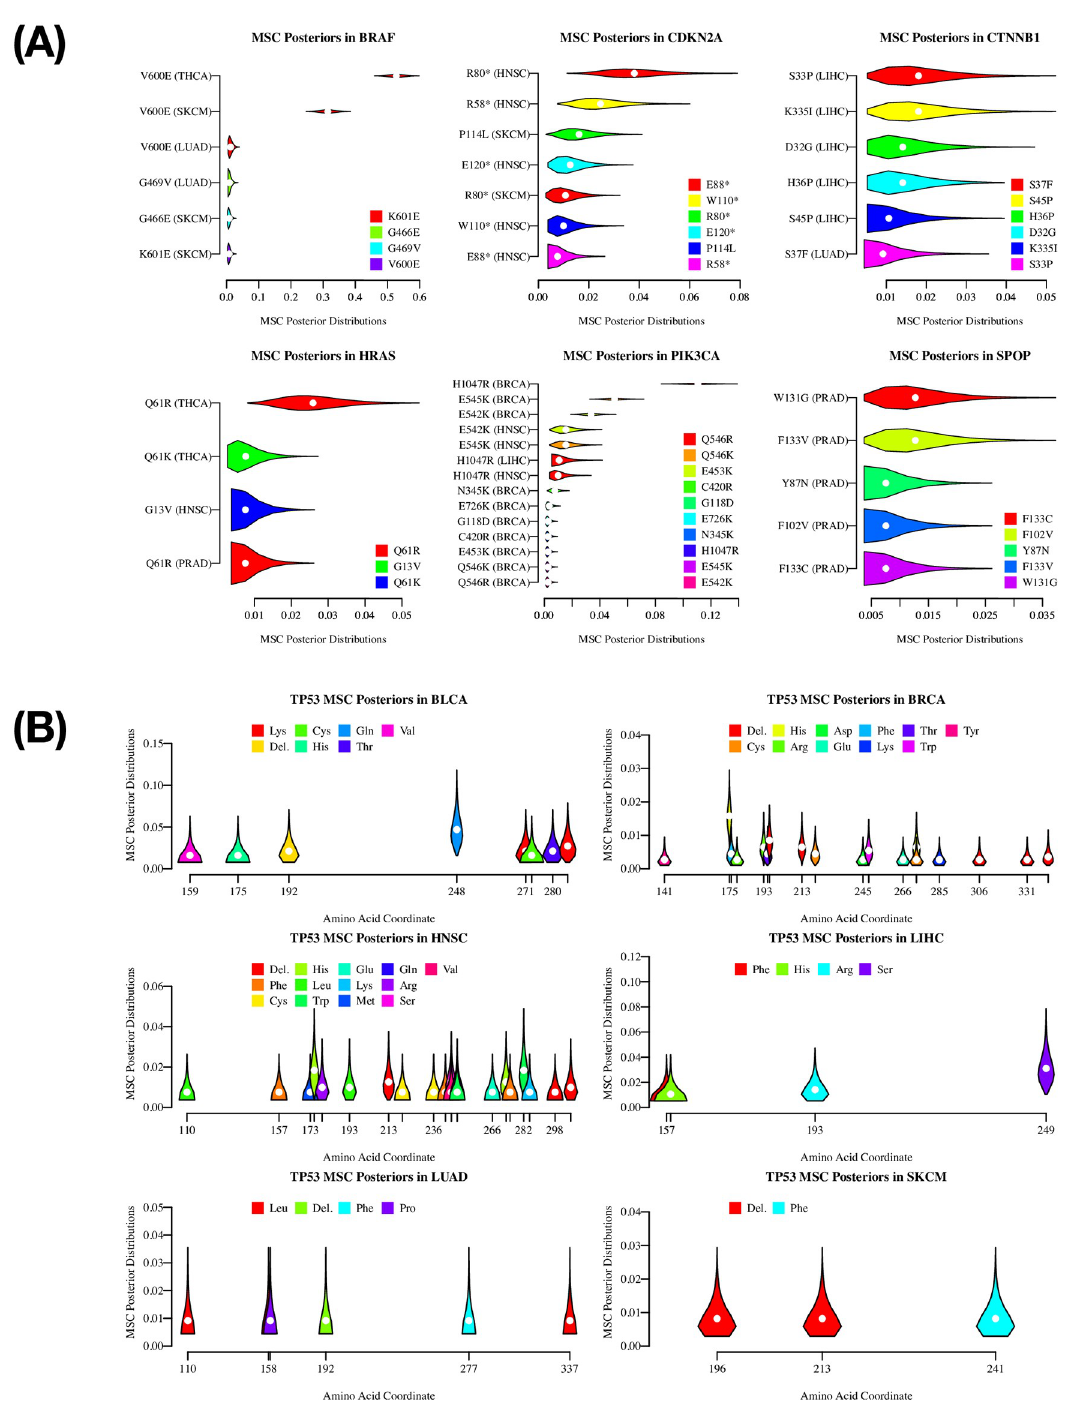
Fig 4. The EAP estimates of driver mutation MSCs. Tumor-type-specific posterior distributions of mutational selection coefficients (MSCs) and EAP (expected à posteriori) estimates in driver-protein mutations calculated by the GEV-binomial model (for details, see Materials and methods). For ease of plotting, we discretized probability densities of posteriors to obtain probability masses. Among the probability masses that count the total number of tumor samples (i.e., the parameter m in the GEV-binomial model), we omitted those tail probabilities that are smaller than 1/1000 in the plot. The white points at the center of each violin in the plots represent EAP estimates given the distribution. The shapes of plotted distributions have information of MFaT tails that cannot be modeled by a simple binomial model. (A) Violin plots of tumor-type-specific posterior distributions of MSCs in genes. Violins are colored according to each amino acid substitution to enable a comparison among MSC distributions of identically coordinated